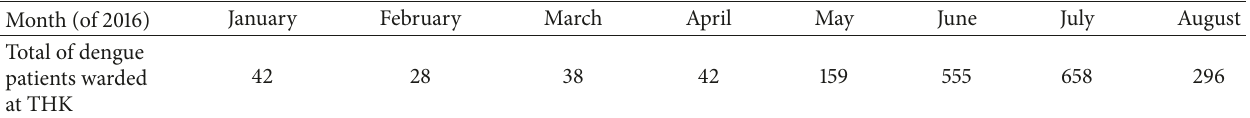
Figure 3: The scheme of buildings of the hospital (in mid-2016). In this scheme, the locations where dengue patients are managed are in tan color. A= building that houses the outpatients department. P= building that houses two pediatric wards. M1 and M2= buildings that house the internal medicine wards. T=nurses training school. The approximate locations of the water containers with Aedes larvae detected by entomological surveys are marked with red dots. Approximate scale of the scheme is given at the bottom. Table 2: Monthly totals of dengue patients warded at